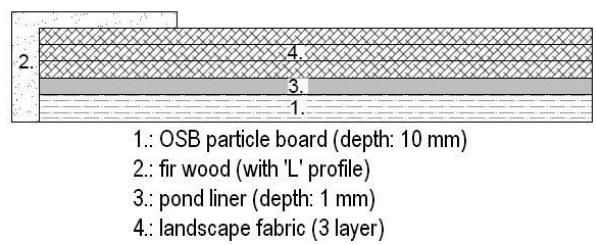
Figure 2. Cross section of moss picture-frames (designed by F ülöp - p ocsai , 2014